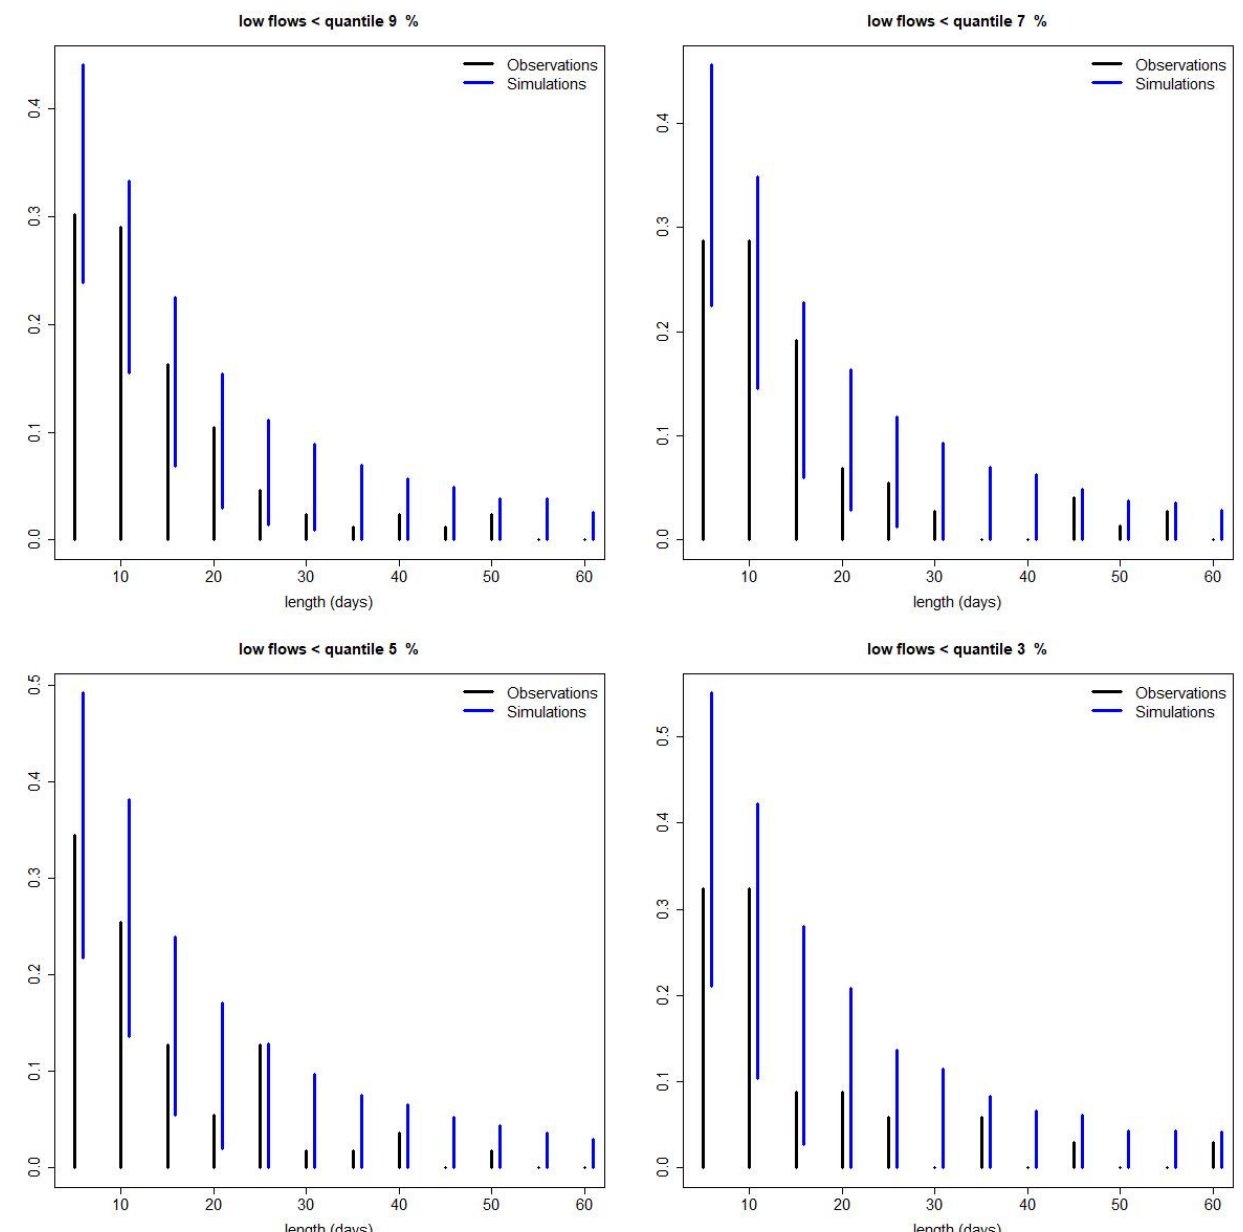
Figure 4. Proportions of low flow sequences of different durations (durations lower than 5 days, between 5 and 10 days, …, between 55 and 60 days) in the time series computed with MORDOR using observed precipitation and temperature (black bars) and 95% interval of the same proportions given by MORDOR using the stochastic simulations of precipitation and temperature (blue segments) for different thresholds defining low flows (quantile 9, 7, 5 and 3% of the observation-based flows).